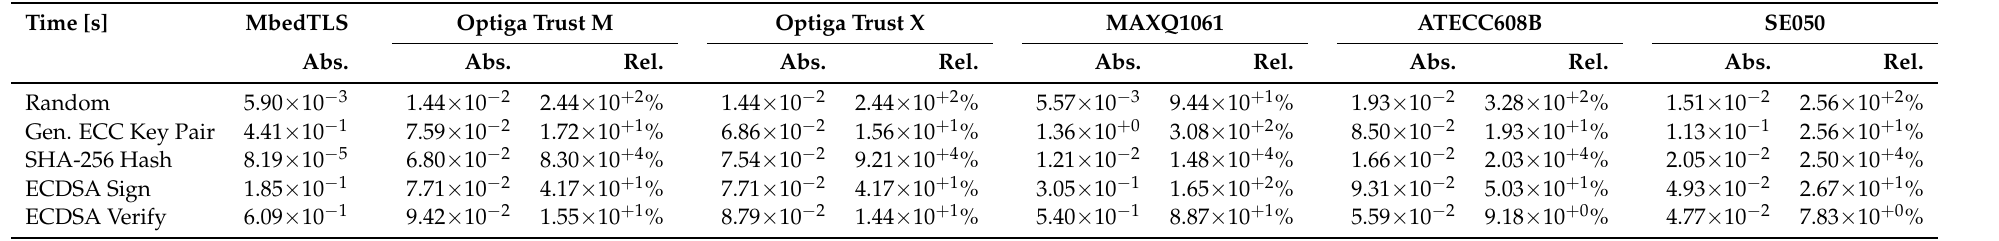
Table A5. Absolute execution time (abs.) of the node (MCU) during the cryptographic primitives using MbedTLS as a reference and absolute execution time of the node (MCU and secure element) during the cryptographic primitives using the secure elements with percentages relative (rel.) to reference (median of values, rounded to 3 significant digits, n = 100).